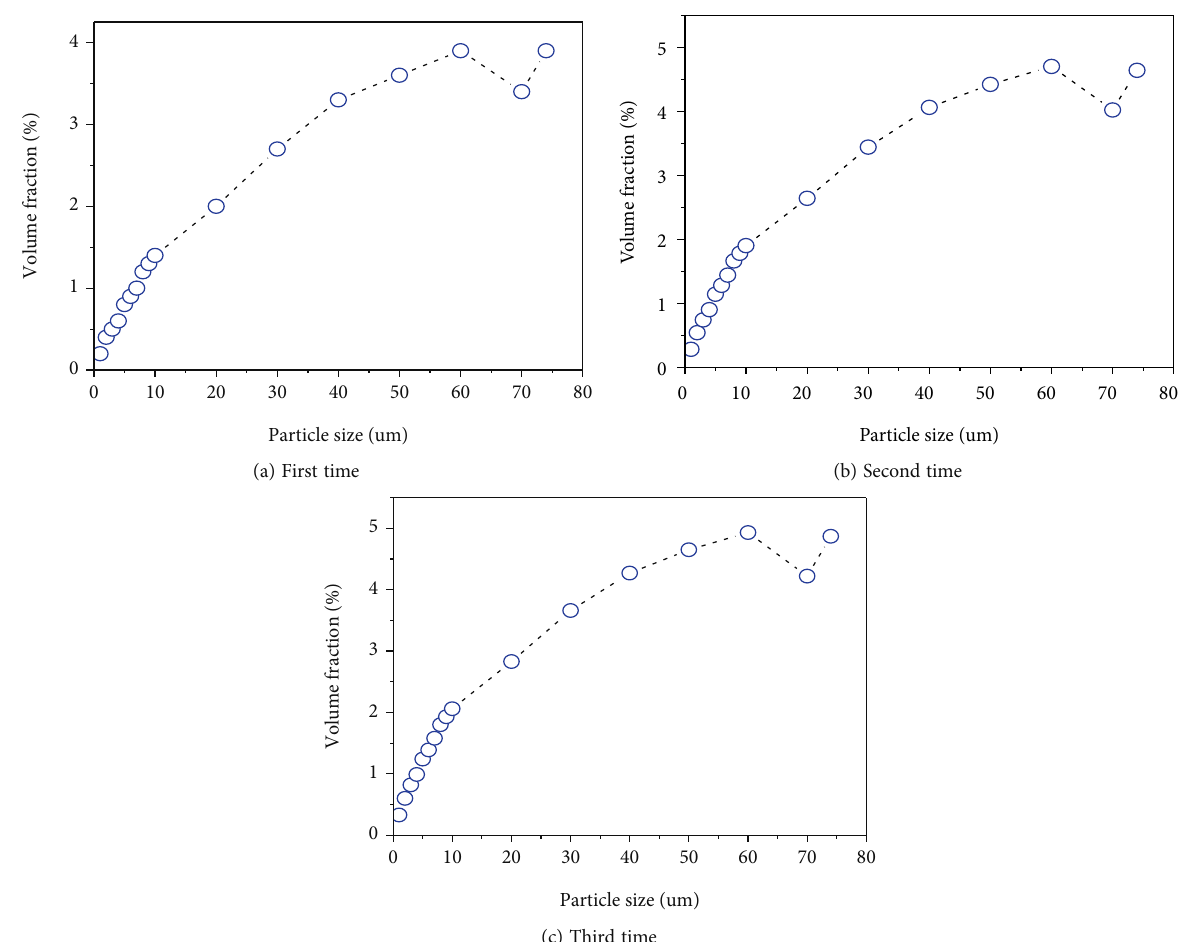
Figure 13: Volume fraction at di ff erent intervals compared with original sample under